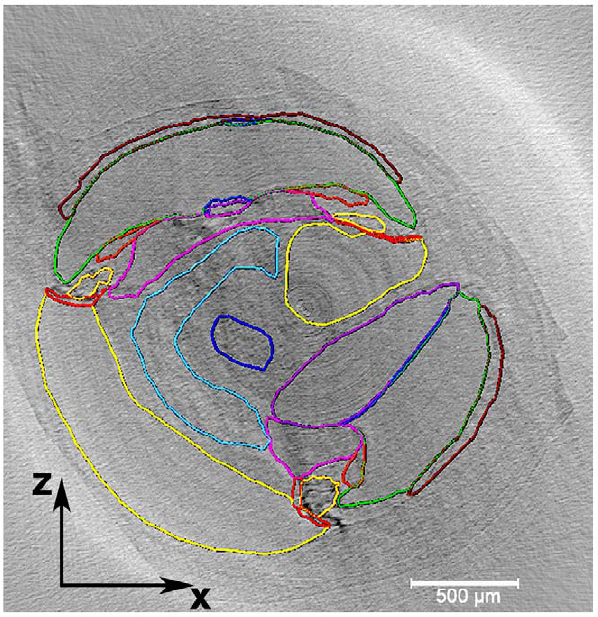
Figure 2. Segmentation of the cochlea. An example of the segmentation seen in the xz-plane. The colored segments (cochlear compartments) were filled in the gray slices using semi-automated algorithm in the Amira software. The purple denotes scala tympani and the green denotes scala media. The yellow denotes scala vestibuli. The periwinkle is spiral ganglion and the dark blue is cochlear nerve. The red is basilar membrane, the light blue is Reissner’s membrane, the orange is tectorial membrane, and the goldenrod is organ of Corti. The pink is spiral limbus and brown stria vascularis.